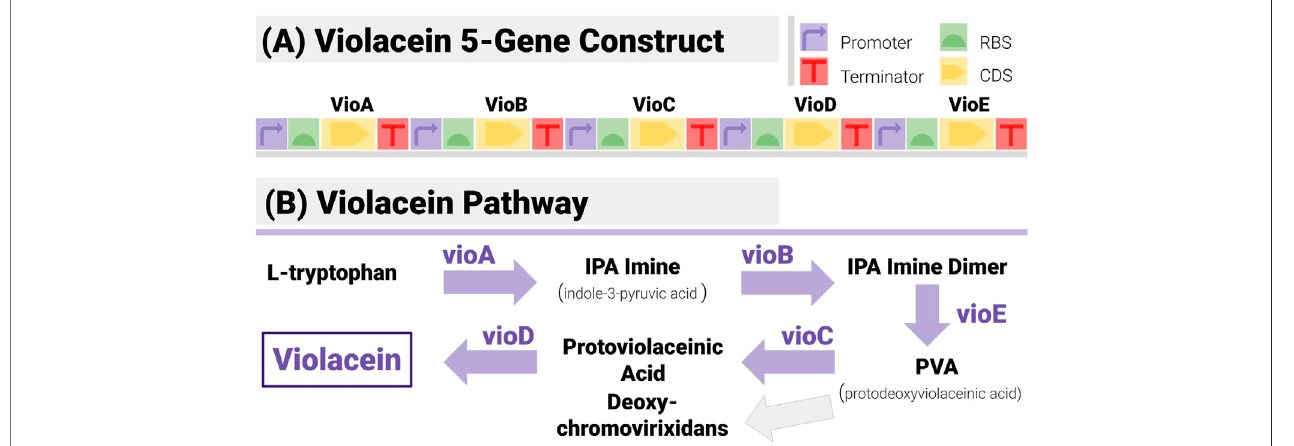
FIGURE6| The5-GeneViolaceinPathwayanditsImplementationwithaTU-Design. (A) Thedesignismadeupof5transcriptionunits(hence20components)ina setgeneorder.Allunitssharethesamepromoter(BBa_J23101)andterminator(BBa_B0015)-providingastifftestforthealgorithm,duetothelargenumberofpotential repetitions. (B) The violacein pathway is made up of fi ve enzymes (VioA to VioE). Its associated regulatory mechanisms have been characterized in several strains including E. coli and Yeast.